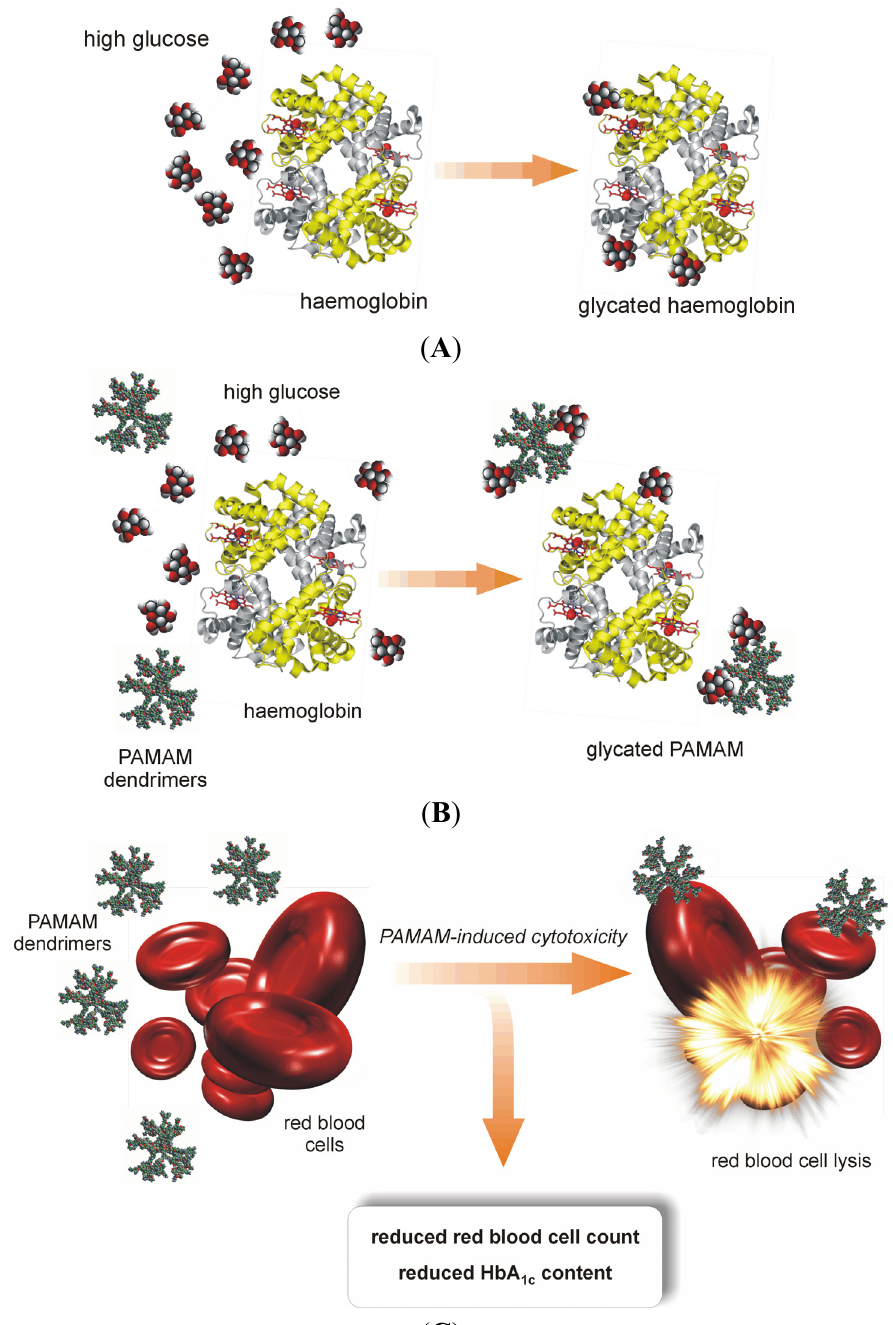
Figure 17. Two hypothetical mechanisms for the lowering of glycated haemoglobin content (HbA ) by PAMAM dendrimers. Excessive glucose leads to increased non-enzymatic 1c glycosylation (glycation) of haemoglobin ( A ), while scavenging of excess glucose by PAMAM dendrimers leads to a lowered rate of haemoglobin glycation ( B ). PAMAM-induced red blood cell haemolysis results in the presence of fewer haemoglobin target molecules, thus reducing the overall extent of non-enzymatic glycosylation of haemoglobin ( C ). Both pathways may result in a decrease in the fraction of haemoglobin molecules that are glycated in animals treated with PAMAM